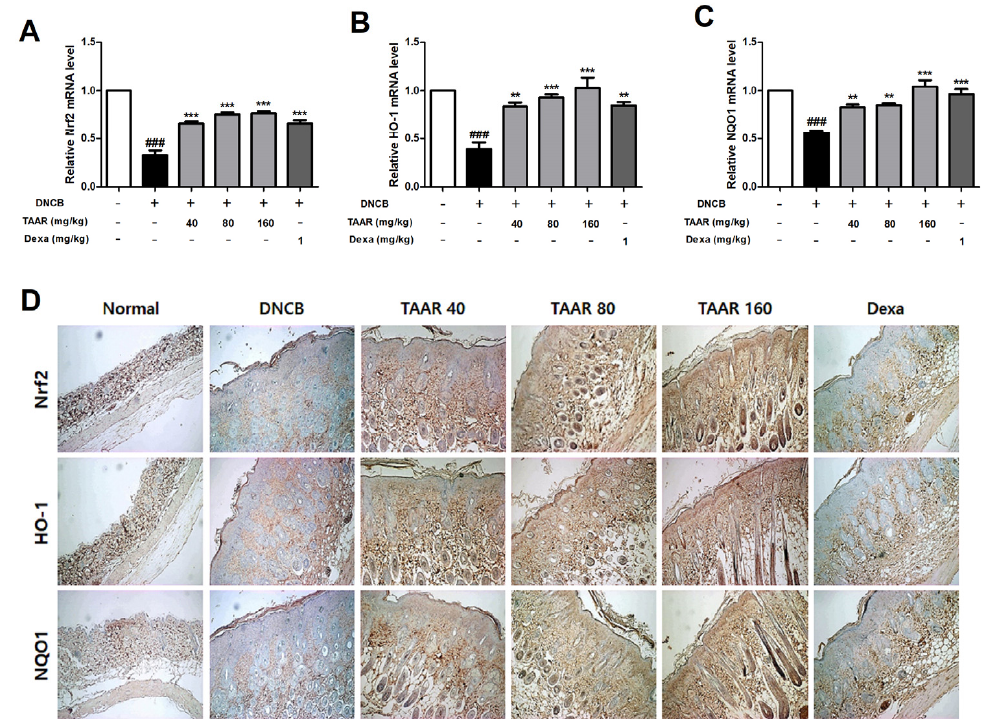
Figure 9. Effects of TAAR extract on the levels of oxidative stress-related factors in the dorsal skin tissue of DNCB-induced mice. ( A – C ) mRNA levels of Nrf2, HO-1, and NQO1 in the dorsal skin tissue of DNCB-induced mice. ( D ) Protein expression of Nrf2, HO-1, and NQO1 in dorsal skin tissue of DNCB-induced mice. (100 × magnification). All values are presented as the mean ± SEM of three experiments. Data were analyzed by Tukey’s post hoc test. ### p < 0.001 vs. normal control group; ** p < 0.01, and *** p < 0.001 vs. DNCB-treated only group.